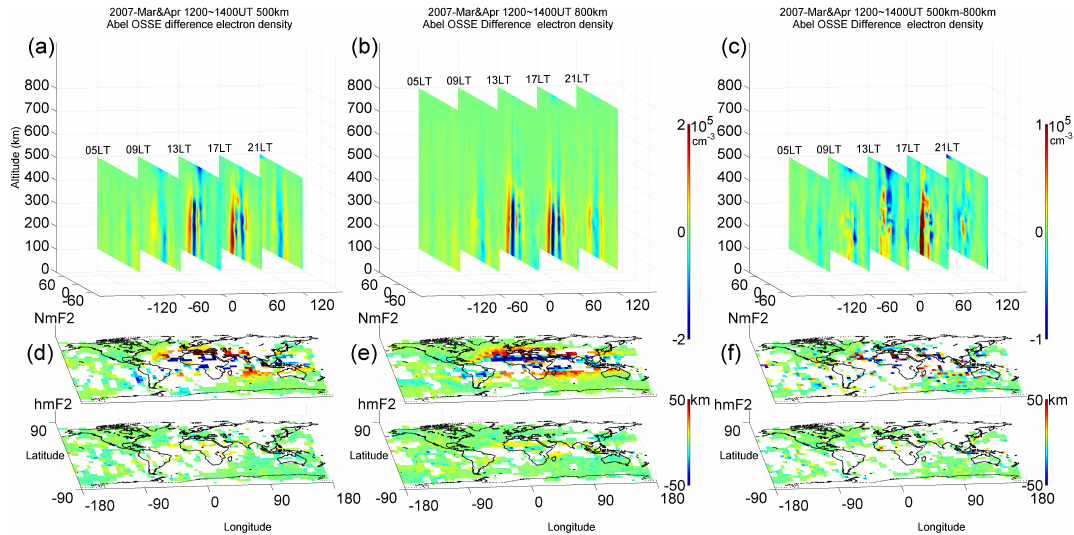
Figure 5. The Abel inversion OSSE error (OSSE result–truth) electron density, Nm F2, and hm F2 observed from 500 and 800km altitude satellites, and their difference during 12:00–14:00UT in March and April of 2007. (a) OSSE electron density error observed from 500km altitude, (b) OSSE electron density error observed from 800km altitude, and (c) their difference. (d) OSSE Nm F2 and hm F2 error observed